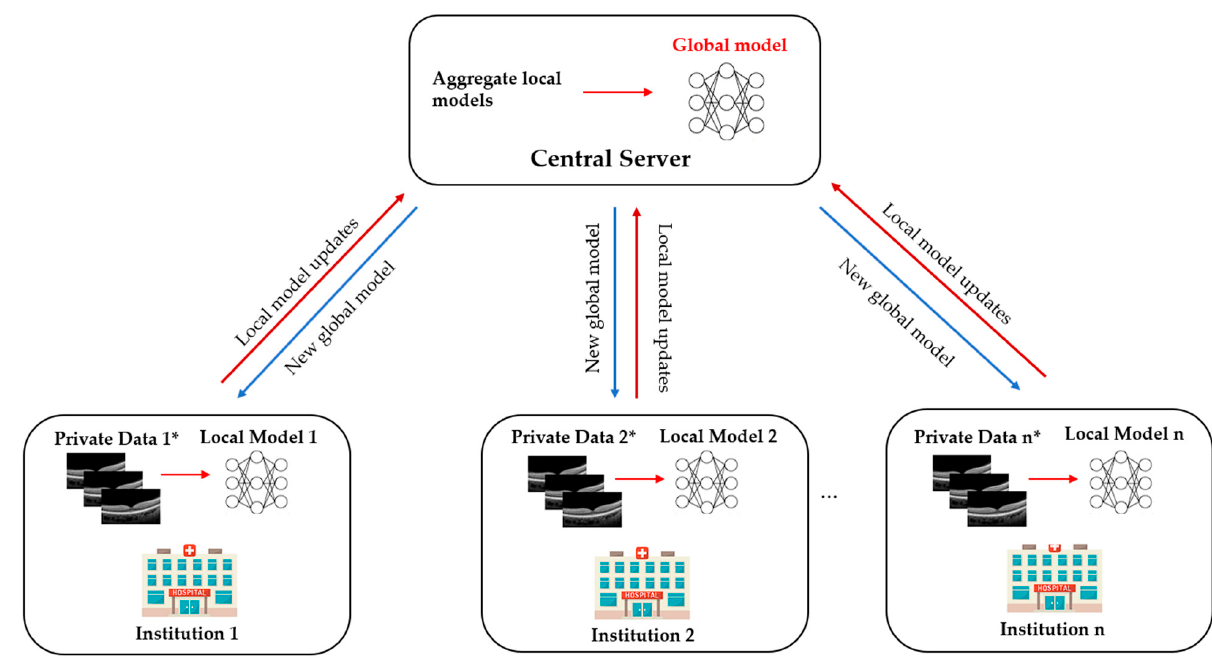
Figure 2. The architecture of federated learning. Each institution trains a local model on its own training dataset. All local models’ parameters are then transferred to the central server after one training epoch. The central server accumulates and aggregates all local parameters and updates the global model securely. Afterwards, the model is updated, and the aggregated parameters are redistributed to each centre for a new round of training. This process is iterated until the global model converges. (*) Optical coherence tomography (OCT) images are illustrated as private data from participating institutions. Other different ophthalmic imaging modalities (e.g., slit-lamp images, fundus photographs, OCT-angiography images) can also be used when exploring the federated learning approach in the field of ocular imaging.